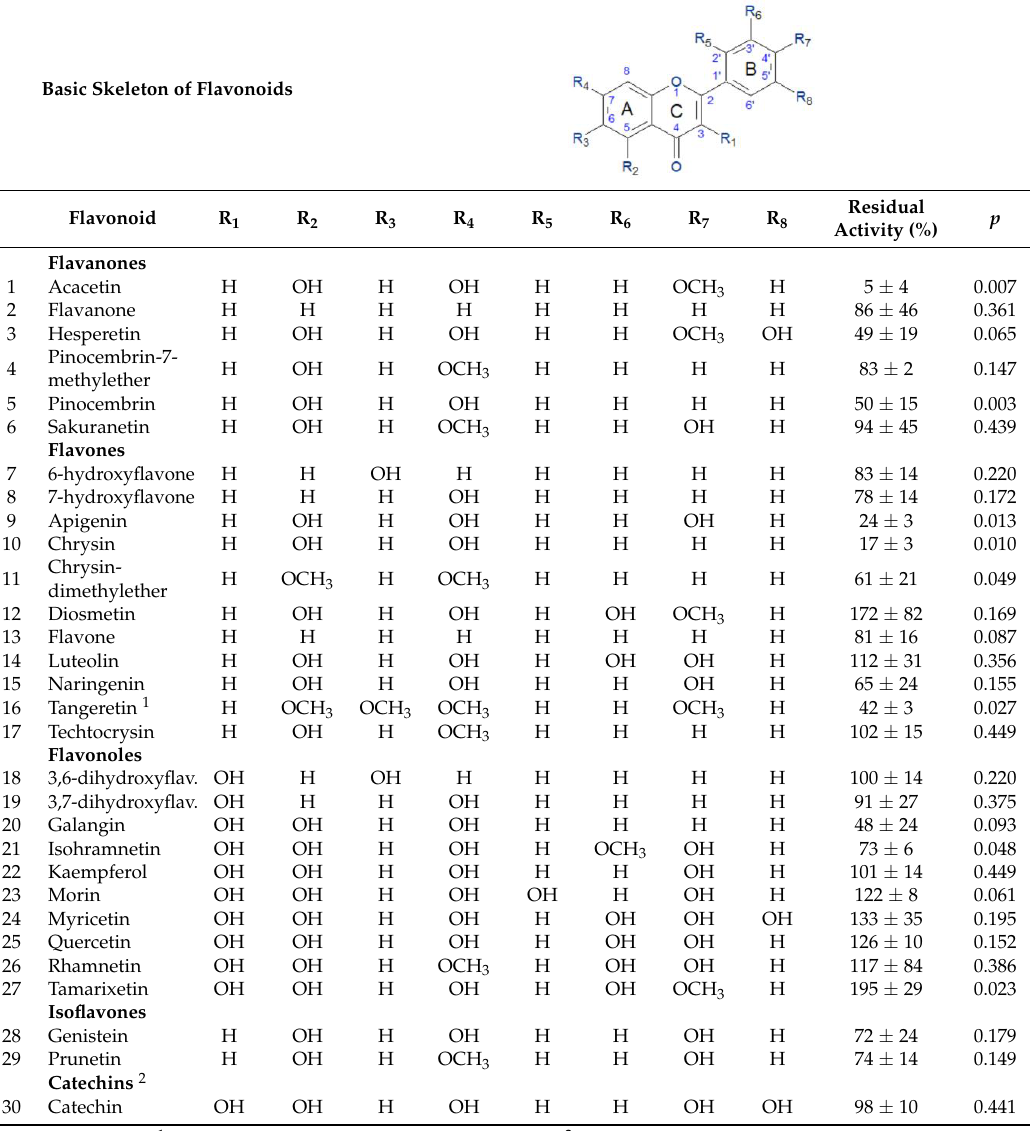
Table 1. Structural characteristics of flavonoids screened as potential inhibitors of CYP3A4 enzyme. Results of screening of metabolism dependent inhibition are expressed as residual enzyme activity when compared to the control without the addition of flavonoid. p denotes statistical significance.